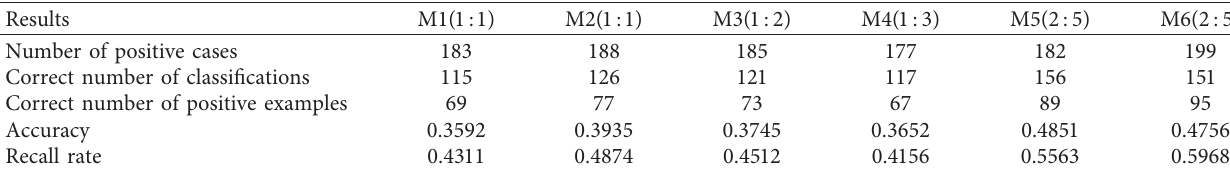
Table 1: Judgment result.